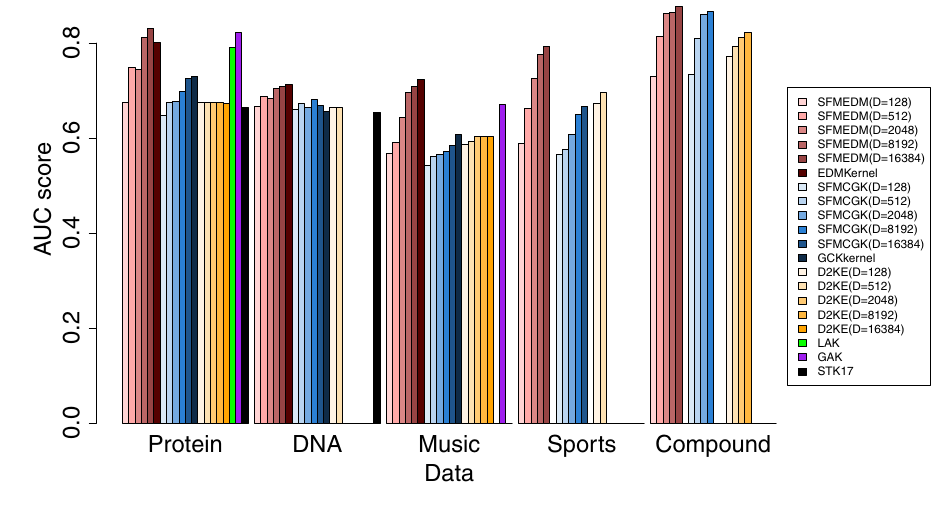
Fig. 5 AUC score for each